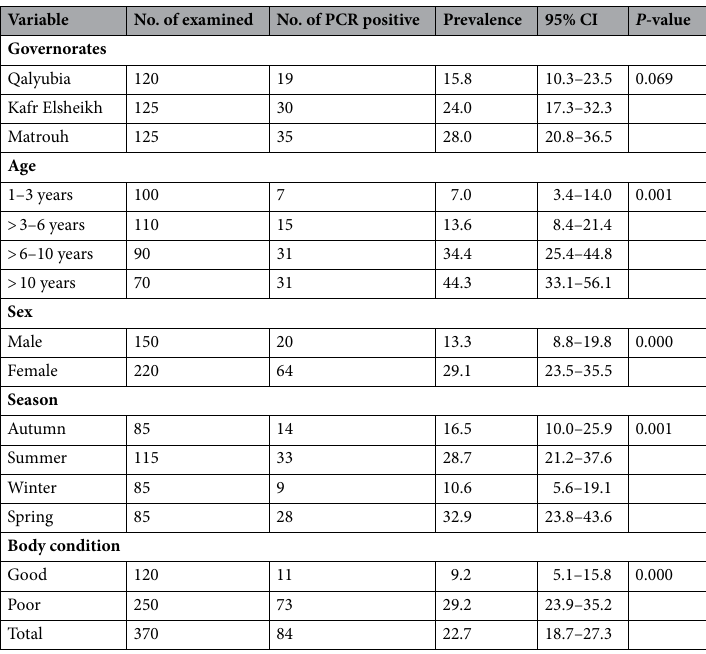
Table 1. Prevalence of camel trypanosomiasis among associated risk factors. CI confidence interval.